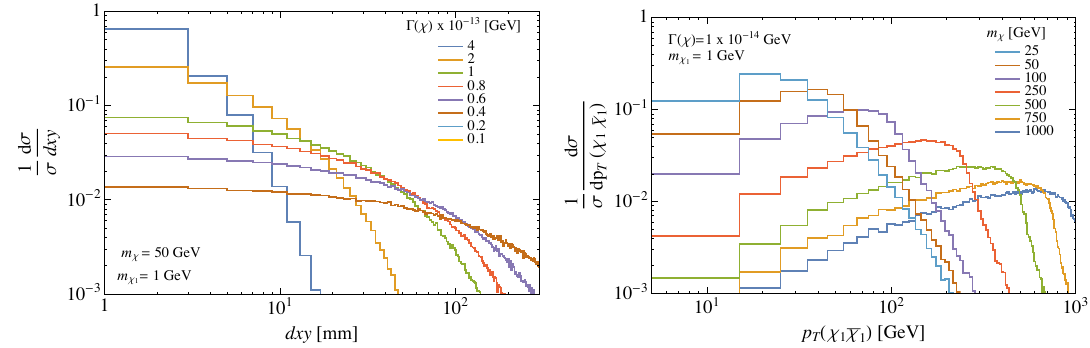
Figure 11 . Left: the transverse impact parameter of (cid:31) the transverse momentum of the DM system ( p T ( (cid:31) 1 (cid:22) (cid:31) 1 )) for various (cid:31) masses. Other parameters in the GMSB model are (cid:12)xed as per the panel headings. The distributions in both panels are